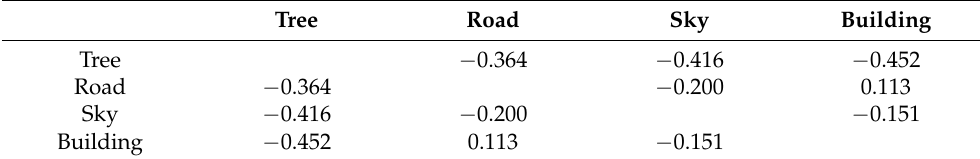
Table 4. Pearson correlation matrix between the proportions of the four detected categories 1 . Tree Road